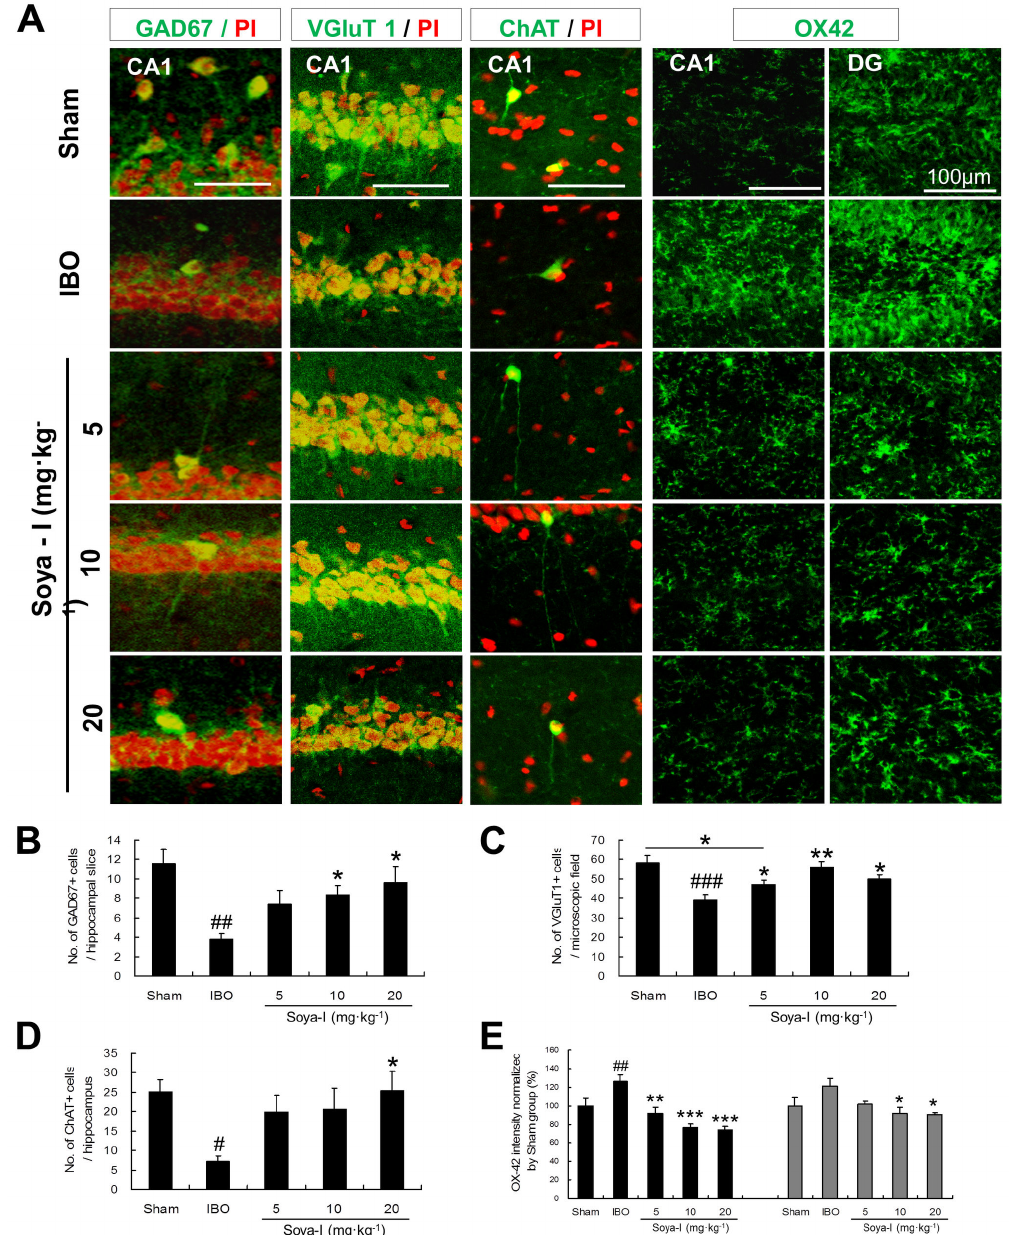
Figure 3. Neuronal cell types and microglia activation affected by soya-Ι administration in memory-deficient rats. A. Confocal laser scanning microscopic images of GAD67, VGluT1, ChAT, OX42-positive cells in the hippocampal region of brain slices (green: marker-positive cells, red: propidium iodide (PI)). B. The numbers of GAD67-positive cells in the hippocampal region of rat brain slices (soya-I-treated and IBO-injected control) compared with the saline-injected sham group. C. The numbers of VGluT1-positive cells in a microscopic field of the CA1 region in the hippocampal region of IBO-injected rat brain slice compared with the sham group. D. The numbers of ChAT-positive cells in the hippocampal region of IBO-injected rat brain slices, compared with the sham group. E. The average intensities of OX42-positive cells in a microscopic field of the CA1 and DG were normalized according to the sham group. The numbers of PI-positive cells were between 80 and 110 cells in a microscopic field. Immunohistochemical analyses were conducted as described in Materials and Methods (intensity of OX42 staining was analyzed using the ImageJ software: http://rsb.info.nih.gov/ij/). Five different animals were used for each treatment group. Data represent means ± SEM ( # p < 0.05, ## p < 0.01, ### p < 0.001, compared with the sham group, * p < 0.05, ** p < 0.01, *** p < 0.001 compared with the IBO group by the Newman-Keuls Multiple Comparison Test). doi: 10.1371/journal.pone.0081556.g003 PLOS ONE |